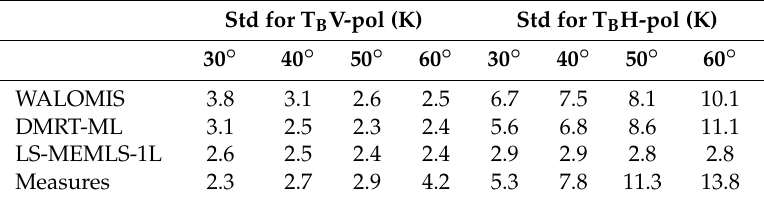
Table 3. Standard deviation (Std) of all the dates and, Scene 1 and 3 together. “All” is the Std calculated with incidence angles of 30°, 40°, 50° and 60°.